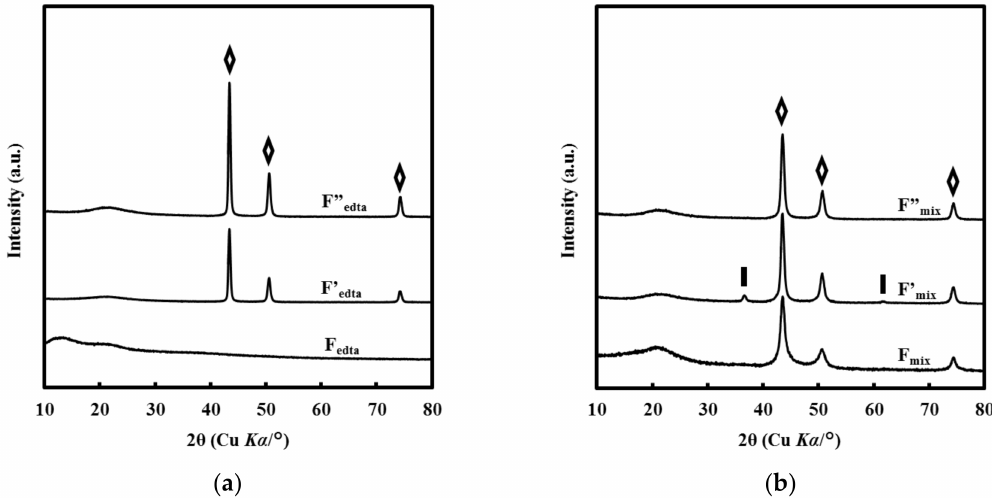
Figure 1. ( a ) X-ray diffraction (XRD) patterns of F edta , F’ edta and F” edta . ( b ) XRD patterns of F mix , F’ mix and F” mix . The peaks are denoted as follows: ♦ Cu and v Cu 2